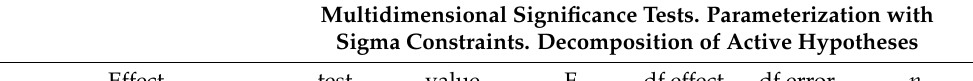
Table 5. Multidimensional analysis.